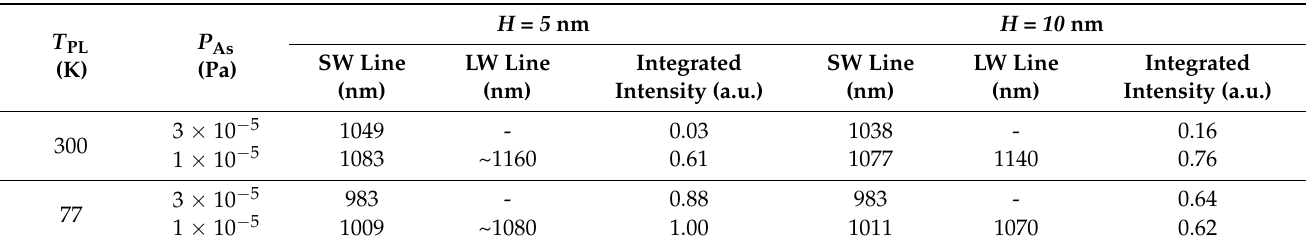
Table 1. Summary of the PL parameters of InAs QDs covered by the LT-GaAs layer under various growth